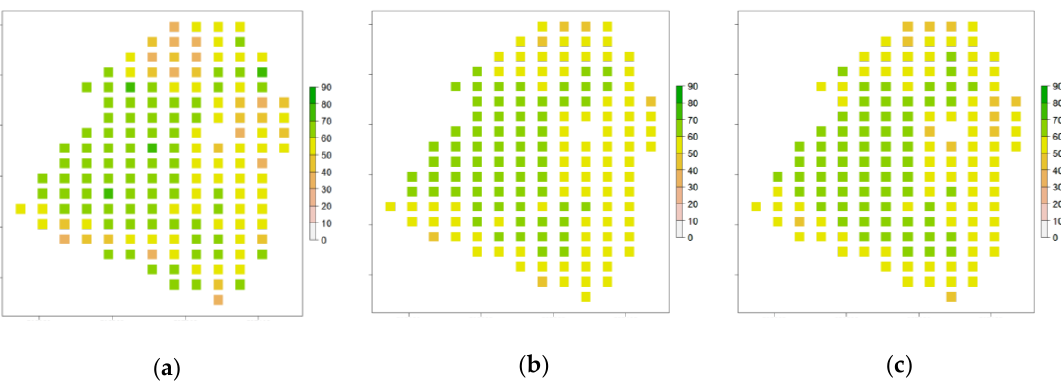
Figure 6. Maps of yield (expressed in q.ha − 1 ) collected in 2017 ( a ), and estimated using multi-temporal NDVI derived from images acquired throughout the agricultural season ( b ), or the combination of satellite data and previous observed yields (collected during the agricultural season 2015) ( c ) on a plot dedicated to the cultivation of wheat.